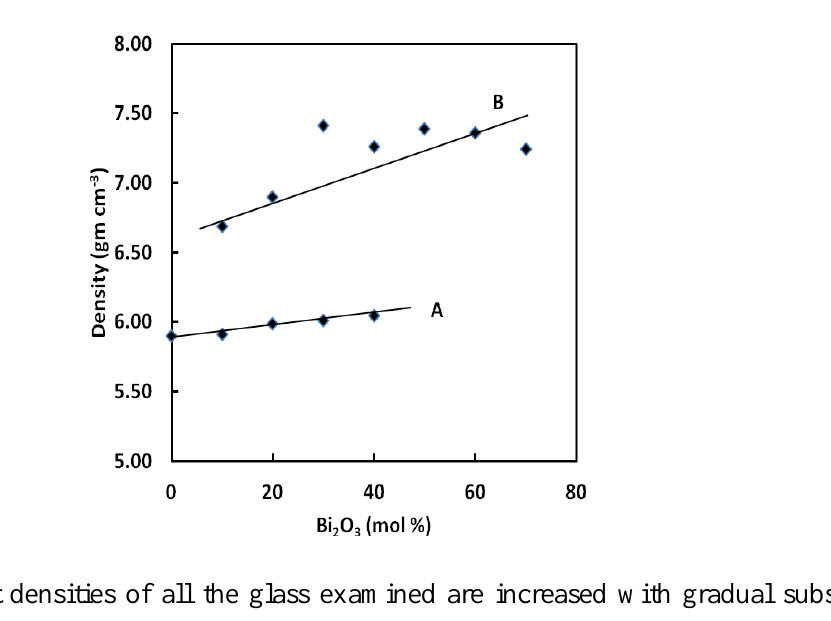
Figure 1. Density of the ternary lead-bismuth germinate glasses of the form (A) and compared with those